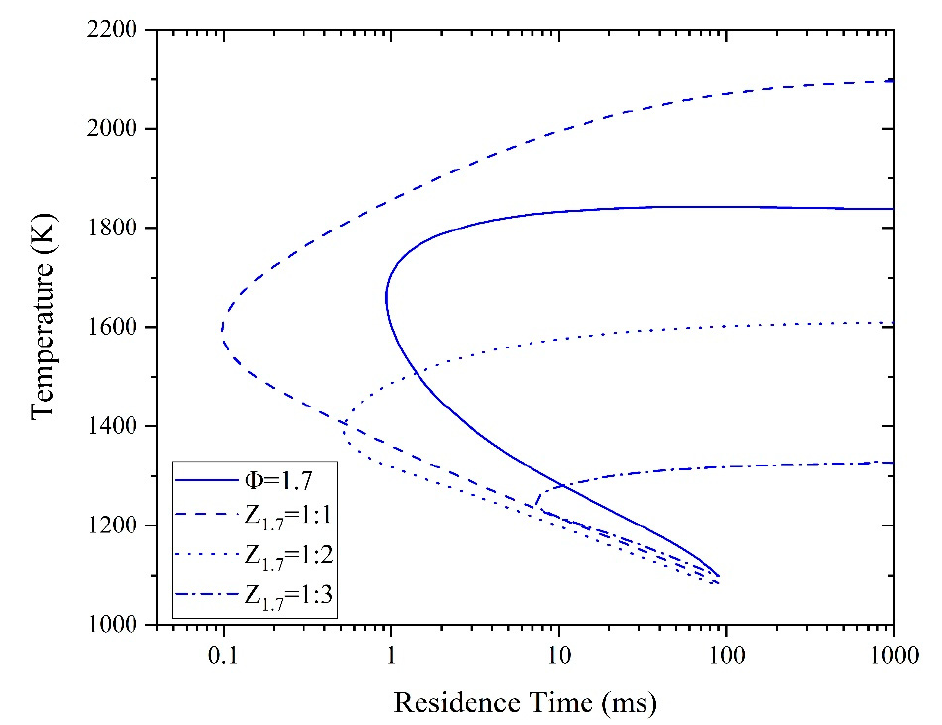
Figure 11. Comparison of C-curves of n -pentane at an equivalence ratio of 1.7 and air–light hydrocarbon mixing gas at mixing degree of 1, 1 / 2, and 1 / 3, respectively.